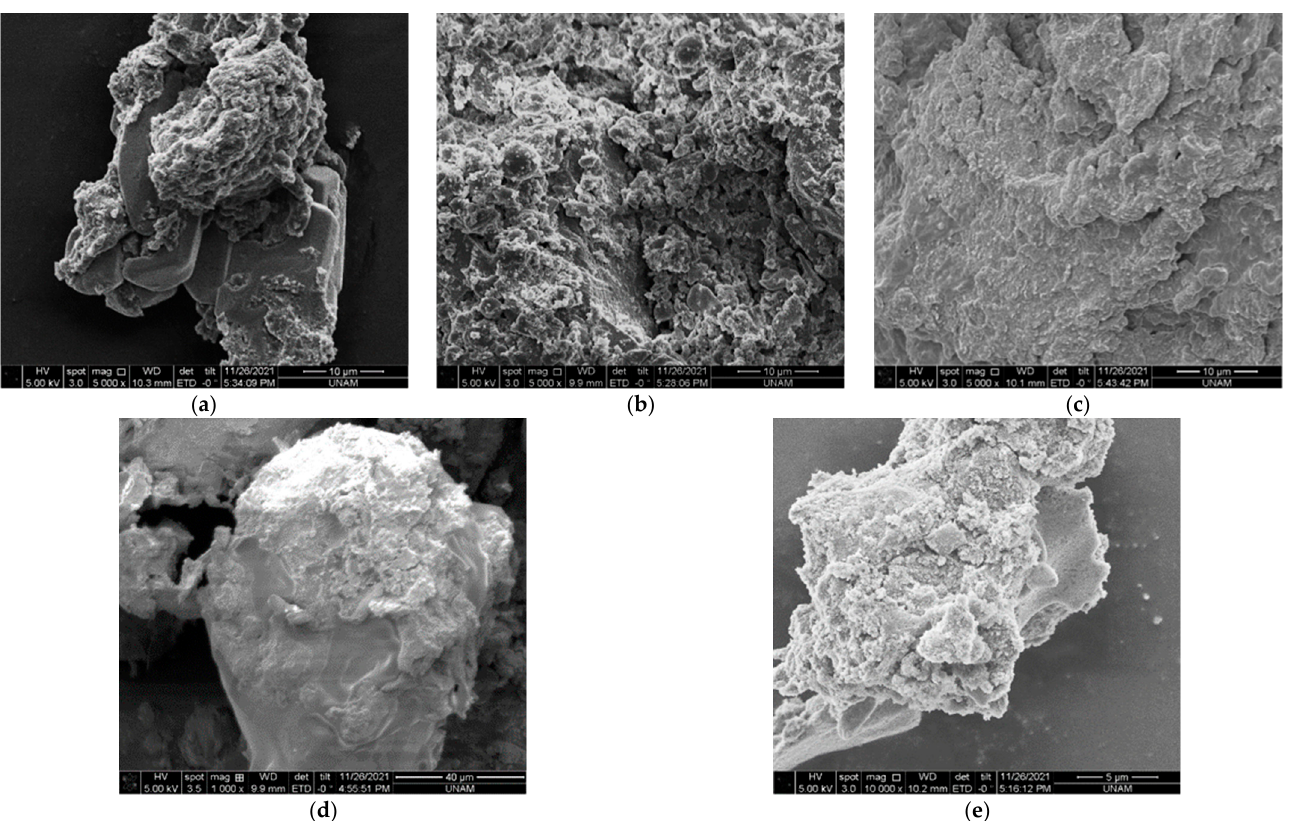
Figure 3. SEM images of PSNC9 ( a ), PSNC14 ( b ), PBSNC2 ( c ), PBSNC6 ( d ), and PBSNC10 ( e ) nano- composites.